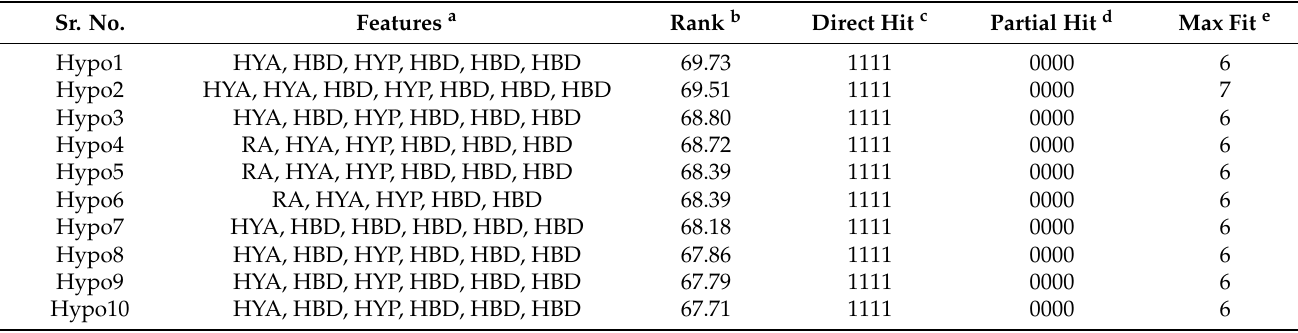
Table 1. The chemical features of 10 hypotheses that were generated for CDK7 using the Hip-Hop algorithm.